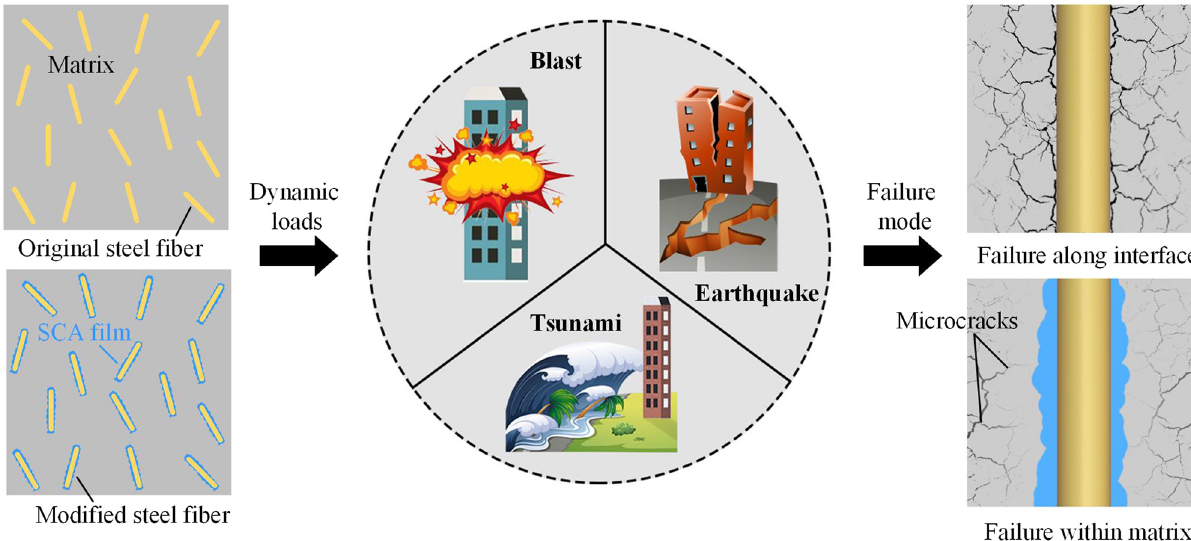
Figure 6: Failure mode of SFRCC with original and SCA modi fi ed steel fi bers under dynamic loads. For SFRCC with original steel fi bers, microcracks appear along the interface due to the weak interfacial performance. For SFRCC with modi fi ed steel fi bers, microcracks appear within the matrix, contributing to a favorable ductile failure